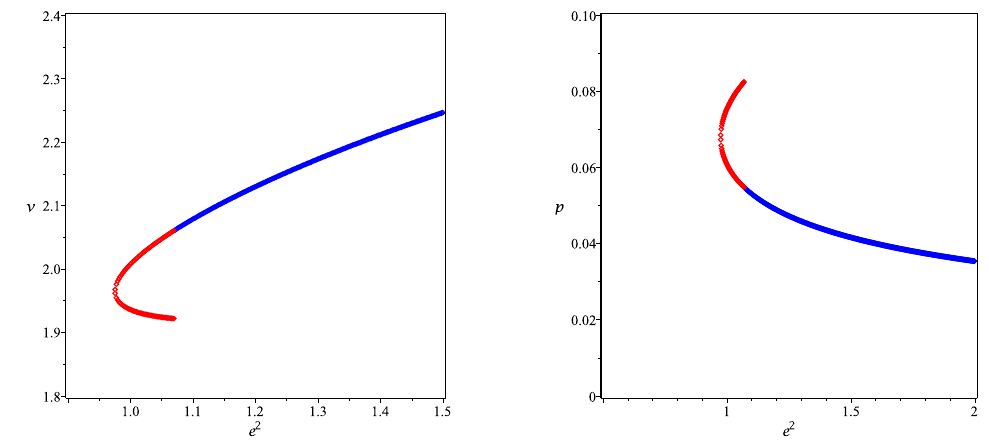
Figure 20 . Counting the number of critical points in six dimensions . In six dimensions, The behaviour of critical volume (left) and critical pressure (right) versus electric charge. We set (cid:22) = (cid:0) 0 : 0675 and k = 1. The red curve shows in which region of electric charge two critical points